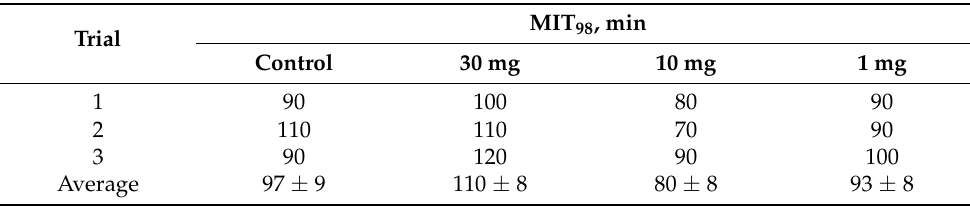
Table 3. The antimicrobial efficiency of annealed MS-TiO 2 -10 (8.7 wt.% Ti) under 365 nm UV light based on minimum inhibitory time MIT 98 measurements for treating a 3 × 10 4 CFU/mL E. coli